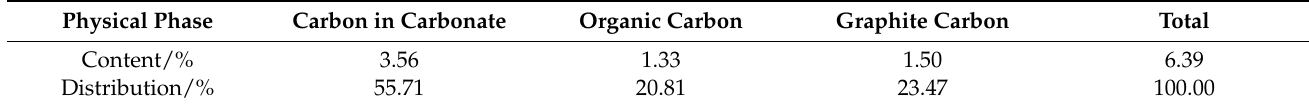
Table 3. Chemical phase analysis of carbon in the raw